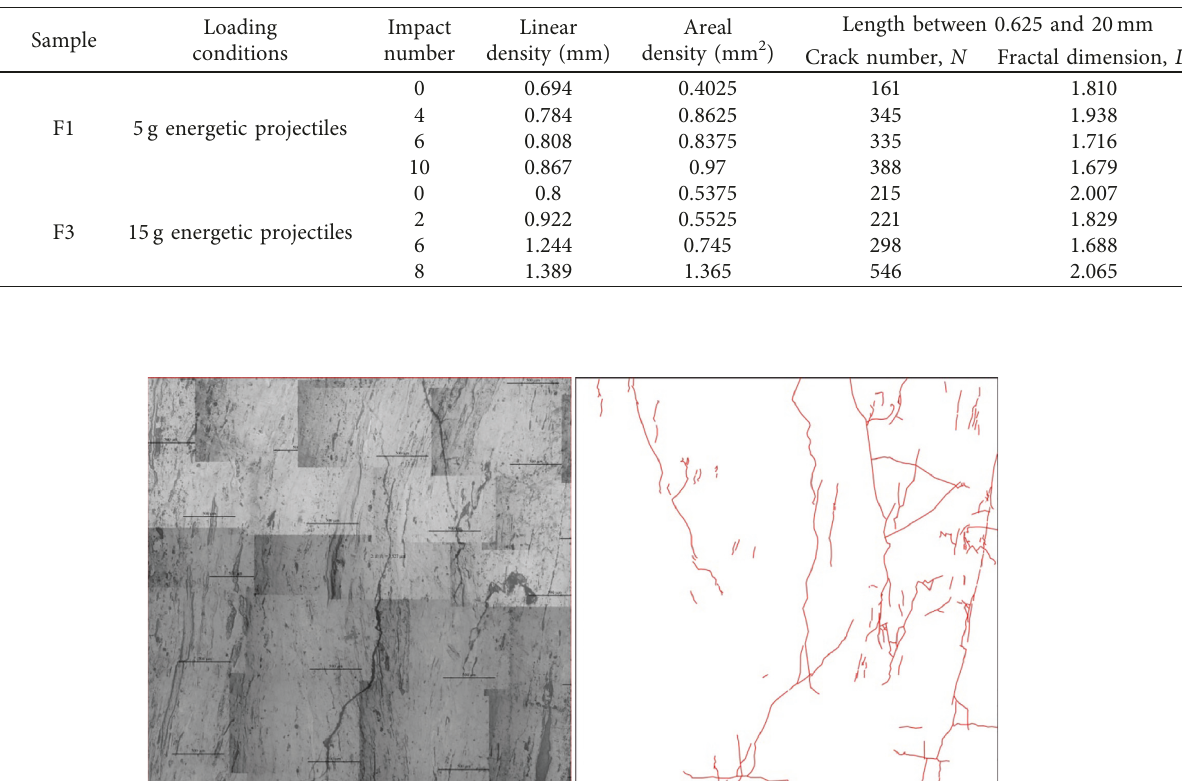
Table 3: Statistics of microcracks of coal samples.